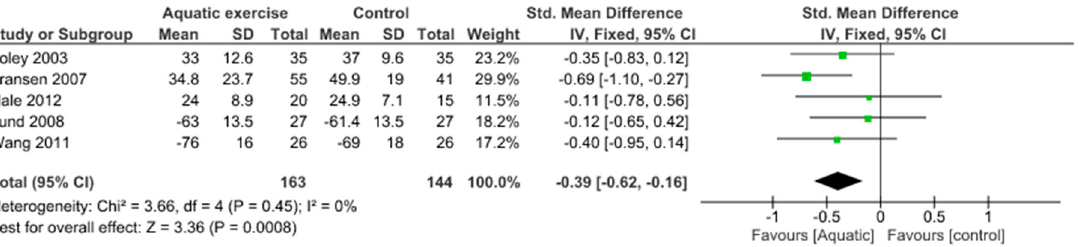
Figure 8. Function: Aquatic exercise versus